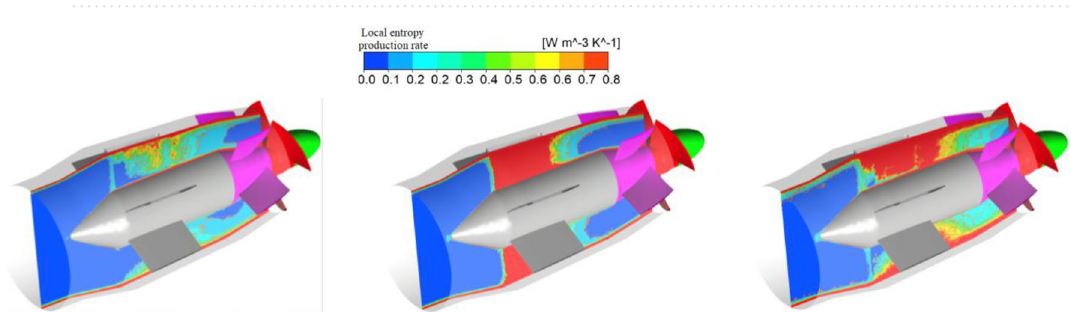
Figure 10. Local entropy production rate distribution in the middle longitudinal section of the bulb and guide